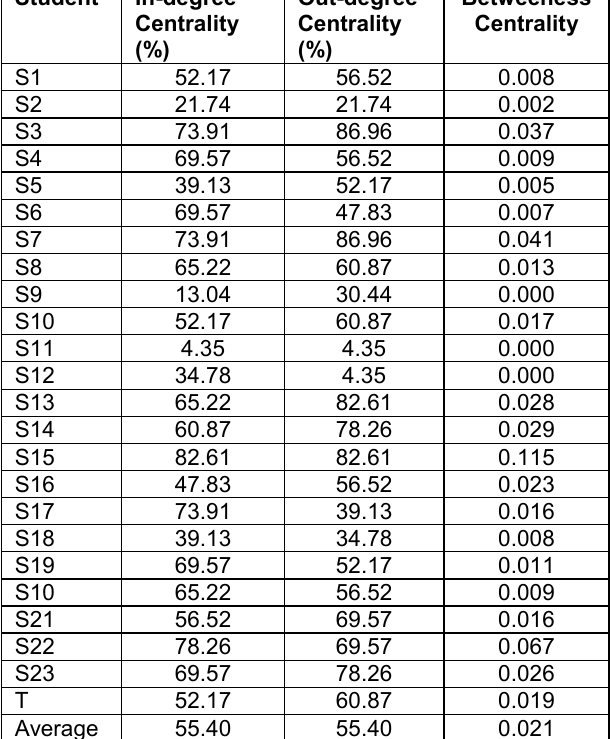
Table 2. Power analysis data